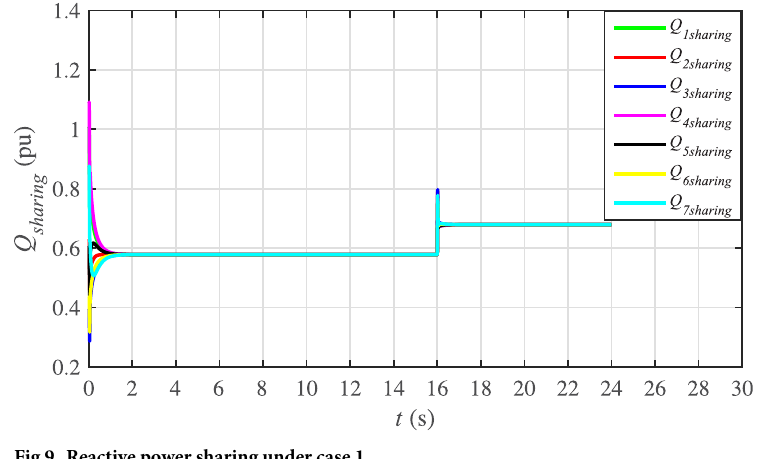
Fig 9. Reactive power sharing under case